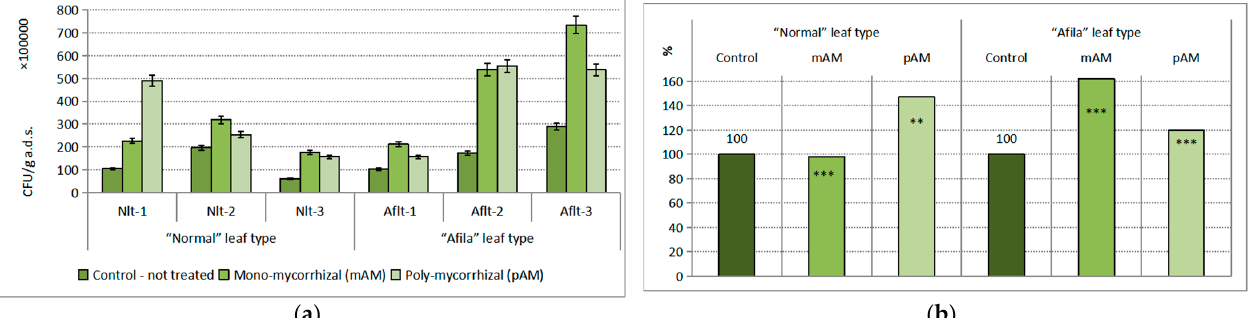
Figure 6. Average population density of the free-living diazotrophic bacteria Azotobacter (CFU ∙ g − 1 absolutely dry soil) in the rhizosphere communities formed after introduction of AM fungi: (mAM) mono-mycorrhizal and (pAM) poly-mycorrhizal inoculants. ( a ) Average values for the particular varieties of garden pea with “normal” leaf type (Nlt-1—cvr. Marsi, Nlt-2—cvr. Plovdiv and Nlt-3— 22/16-n) and “afila” leaf type (Aflt-1—cvr. 22/16-af, Aflt-2—cvr. Kazino and Aflt-3—cvr. Echo).